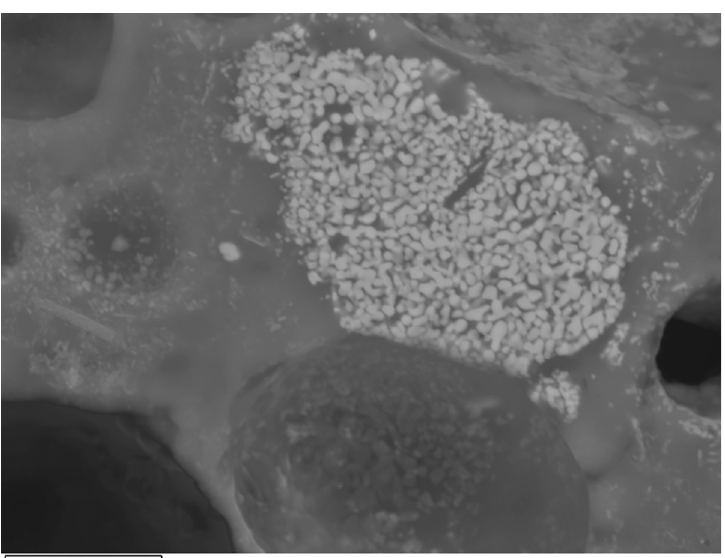
Fig 11. BSE micrograph of H12 showing a partially dissolved Fe silicate mineral in the glassy matrix. Note it is not surrounded by Cu-bearing phases. (Scale = 10 μ m).